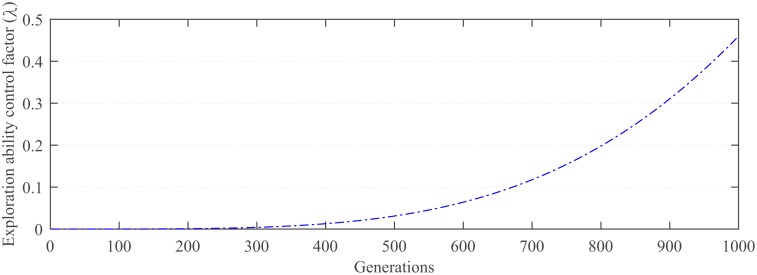
The dynamic adjustment curve of λ.